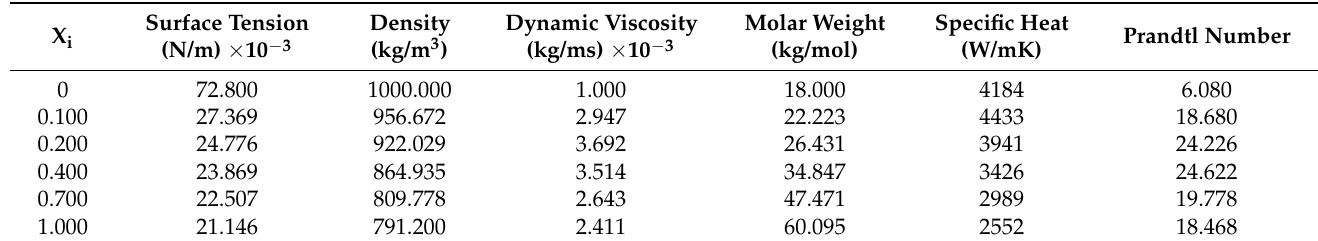
Table 3. Physical properties of the water + 2-propanol mixture with corresponding ethanol molar fraction values at the temperature of 293 K. The datasets are taken from [26–28]. Surface X i